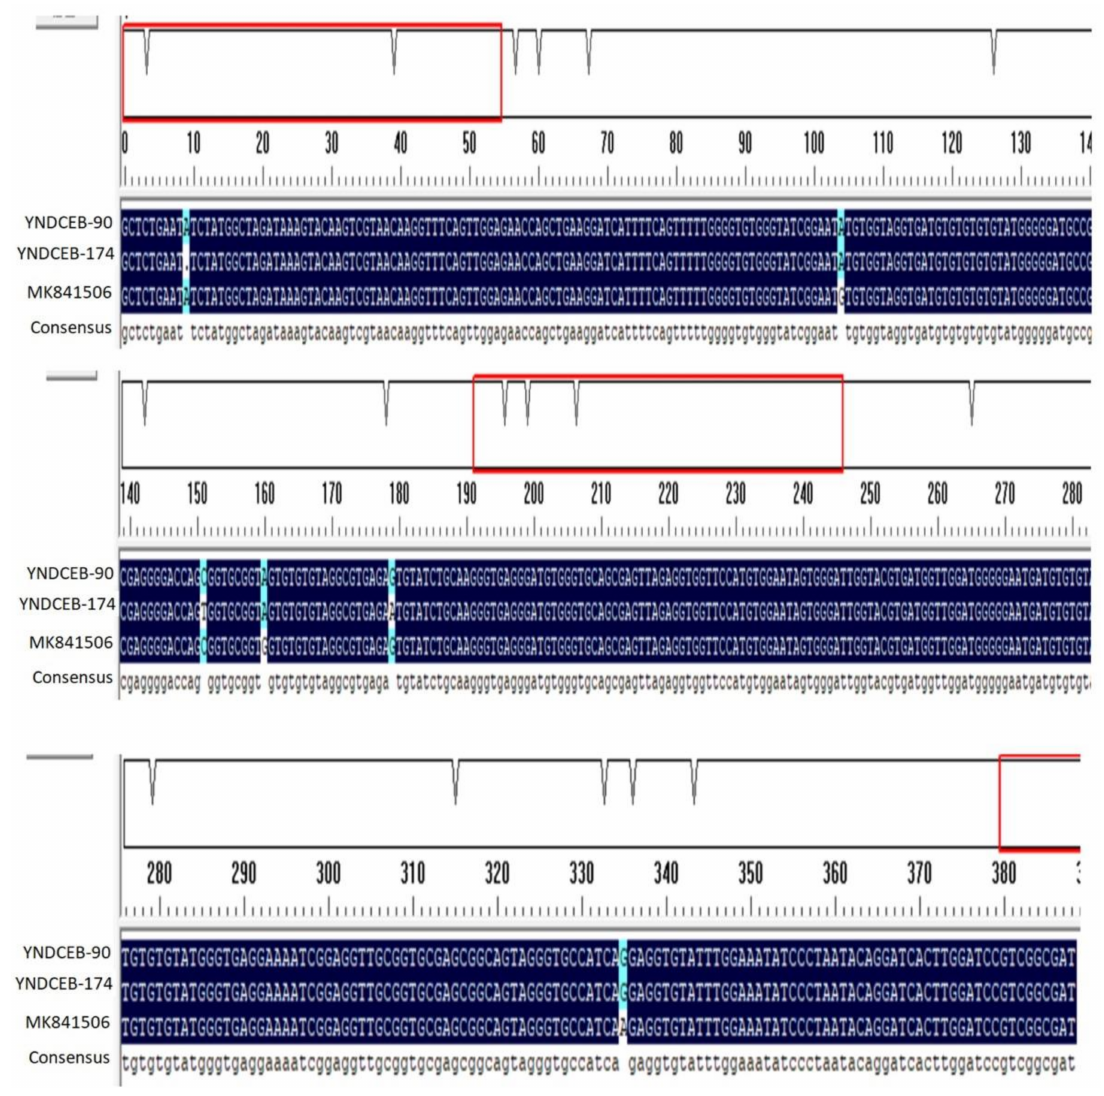
Figure 1. Sequence variation in the ITS region of the rRNA gene of E. bieneusi isolates. The ITS sequences of one known genotype MK841506 (genotype J) and two novel genotypes (YNDCEB-90 and YNDCEB-174) were identified in this